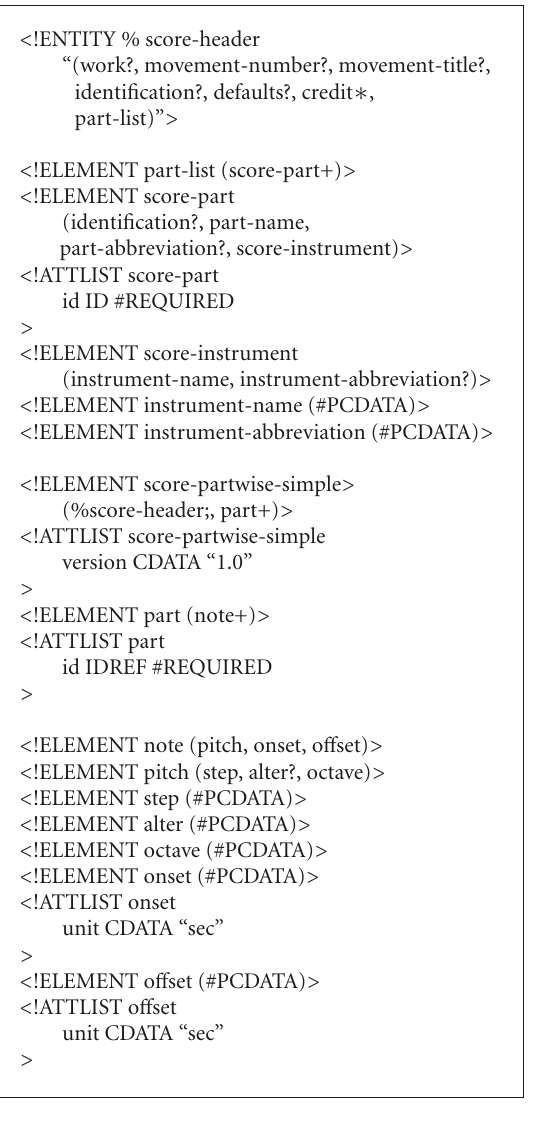
Figure 7: DTD of our simplified MusicXML.